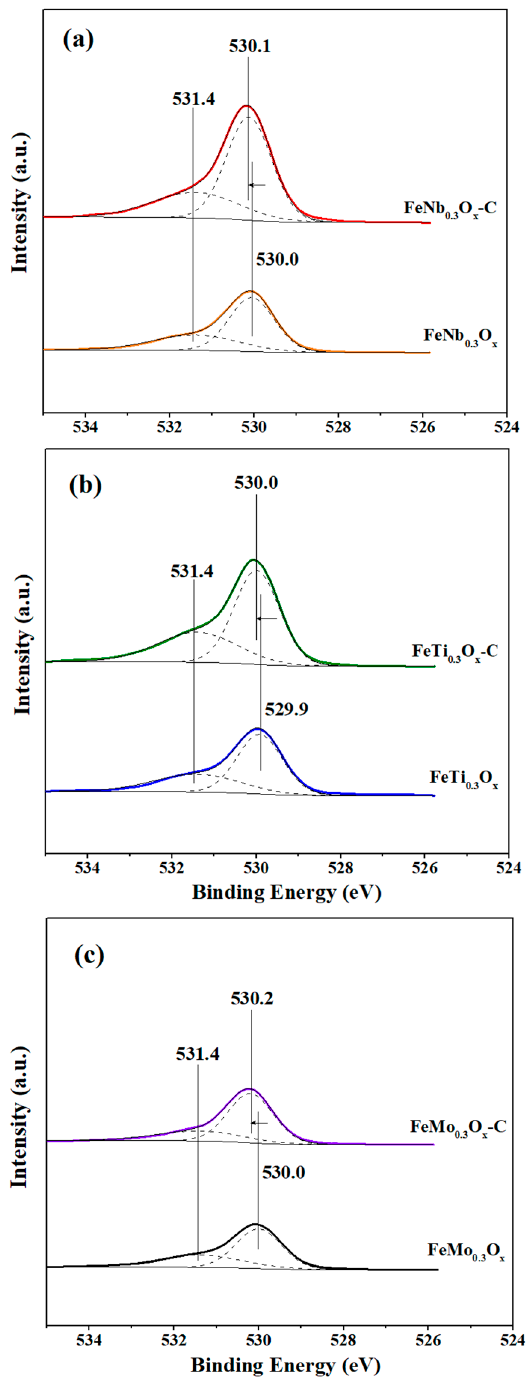
Figure 5. XPS spectra of O 1 s over ( a ) FeNb 0.3 O x -C and FeNb 0.3 O x ; ( b ) FeTi 0.3 O x -C and FeTi 0.3 O x ; ( c ) FeMo 0.3 O x -C and FeMo 0.3 O x . Table 4. Surface components of all the FeM 0.3 O x -C and FeM 0.3 O x (M = Nb, Ti, Mo) samples from XPS results.